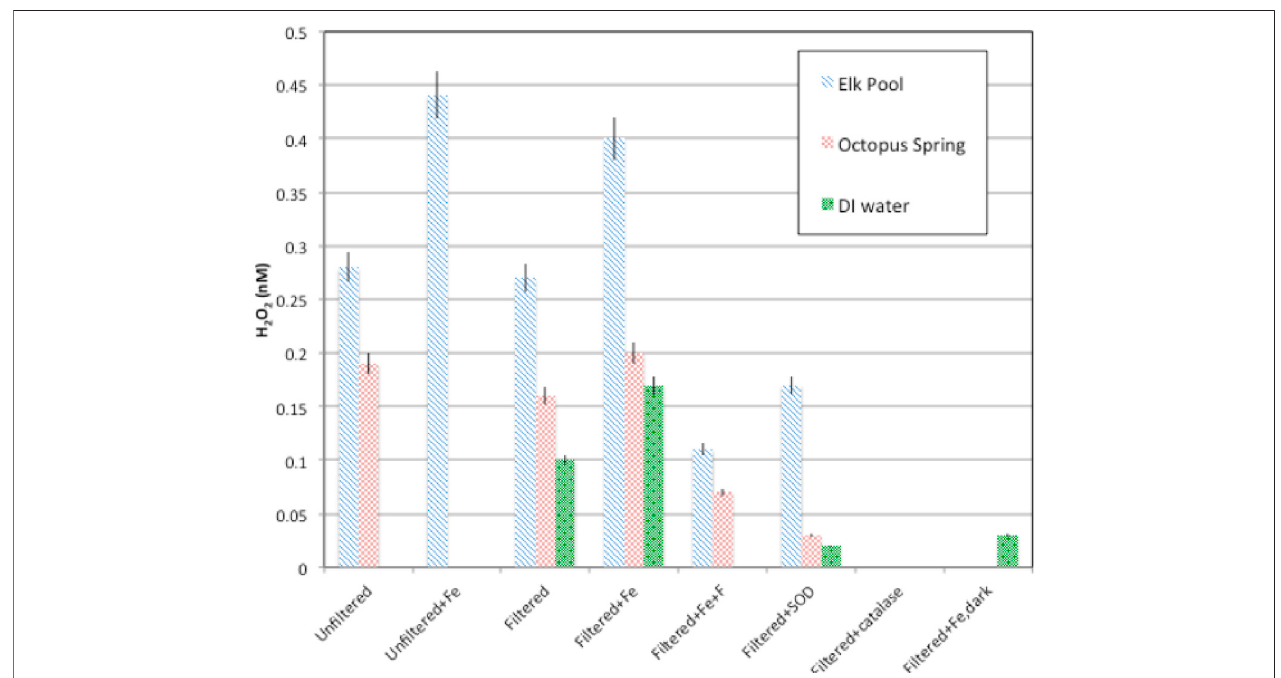
TABLE 3 | Summary of results from fi eld